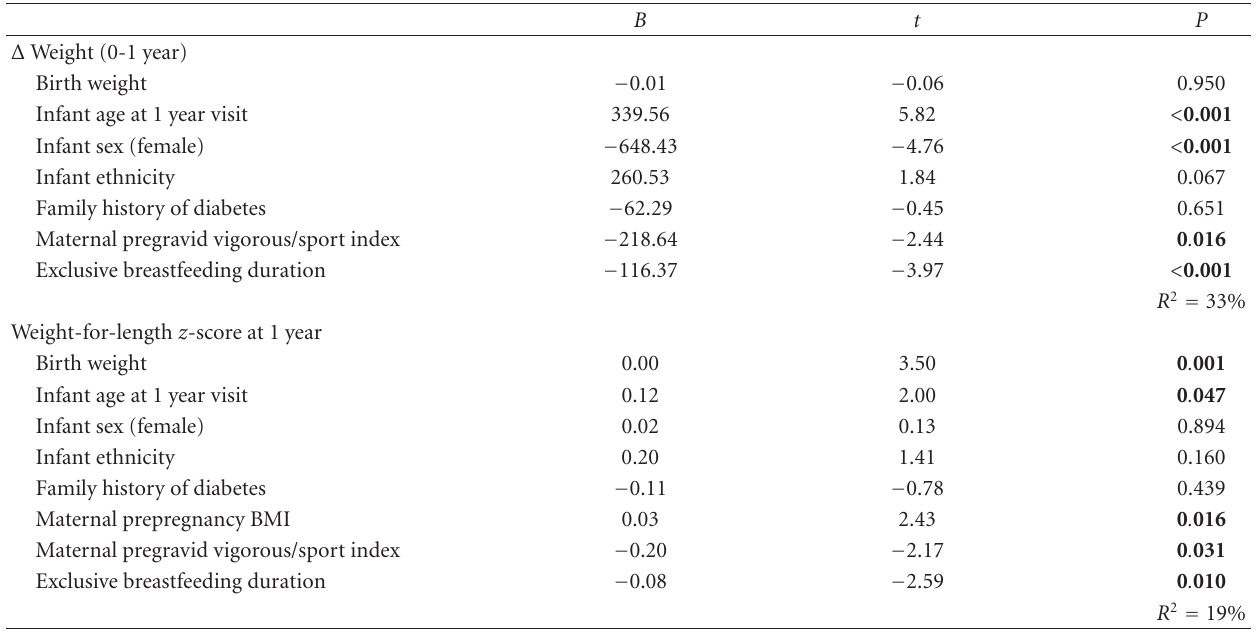
Figure 1: Age of introduction to formula (a) and screen time (b) on infant weight gain at 1 year. Table 3: Multiple linear regression analysis of dependent variables Δ weight (0-1 year) and weight-for-length z -score,